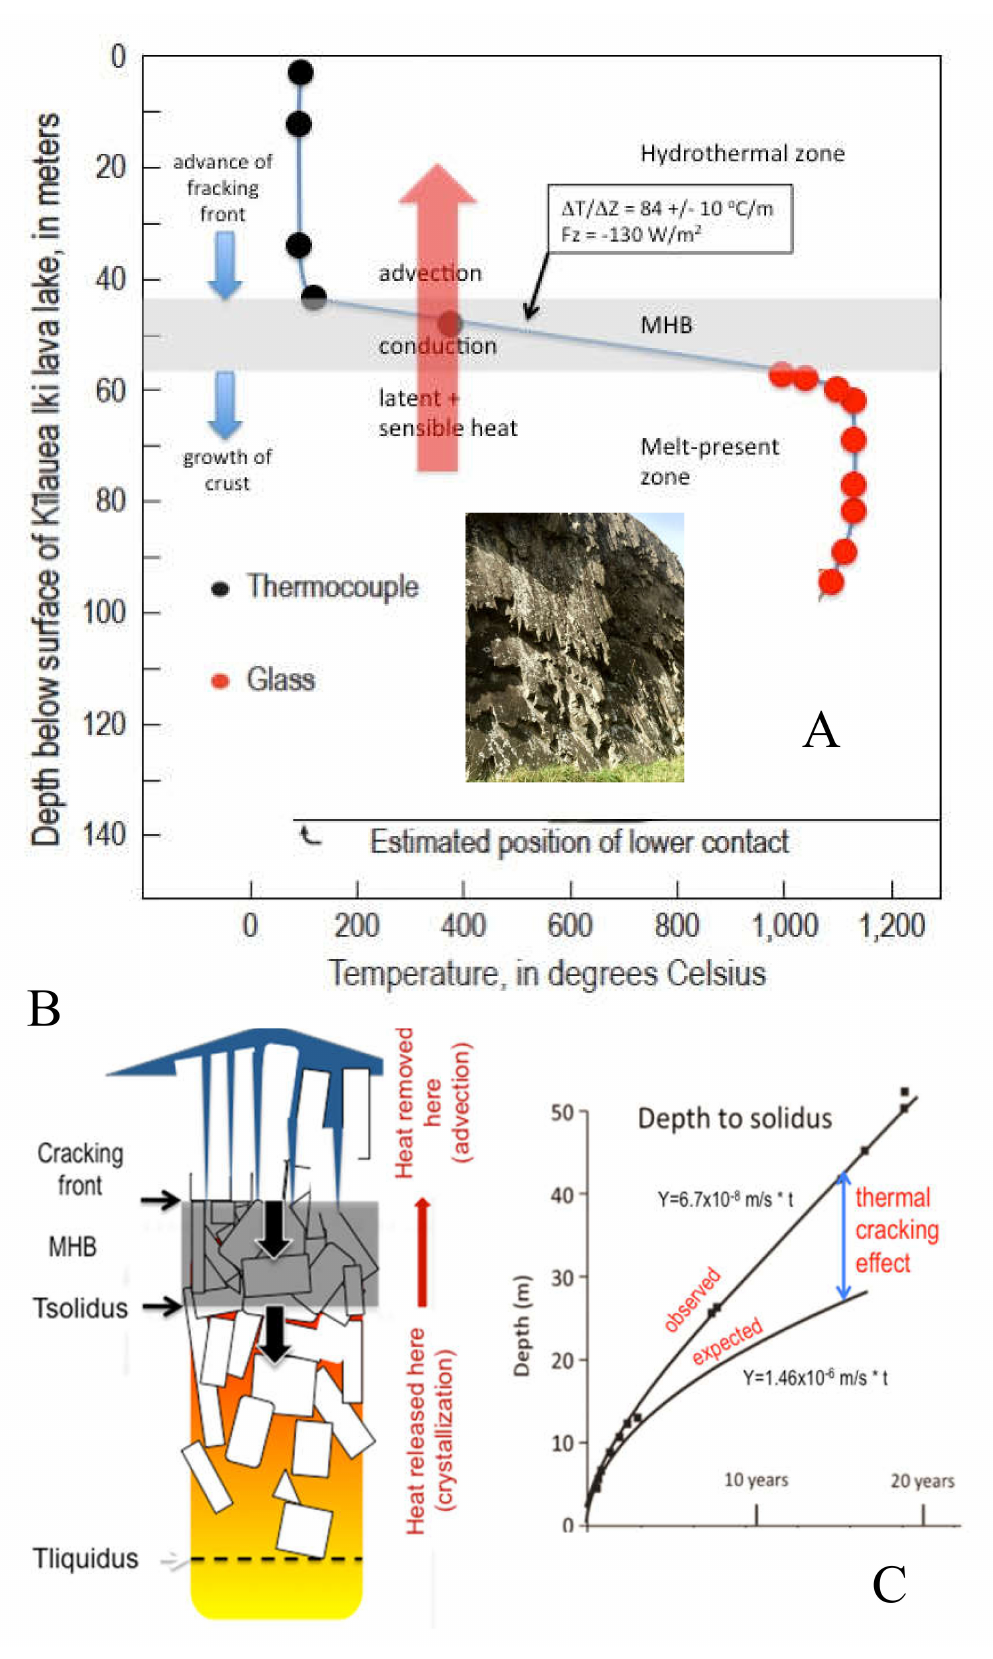
Figure 2. ( A ) A temperature profile from the surface into the melt lens in Kilauea Iki, 1981